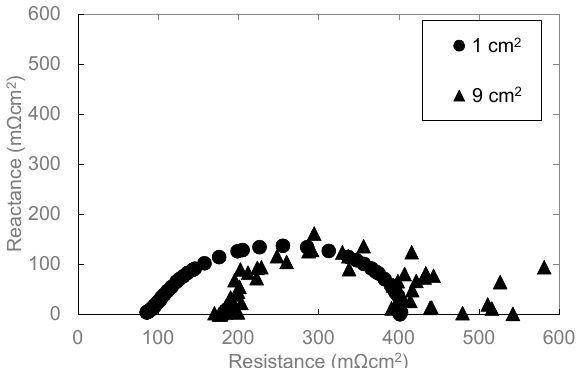
Figure 10. Influence of the electrode area on Cole–Cole plot under 0.1 A/cm 2 of current density.